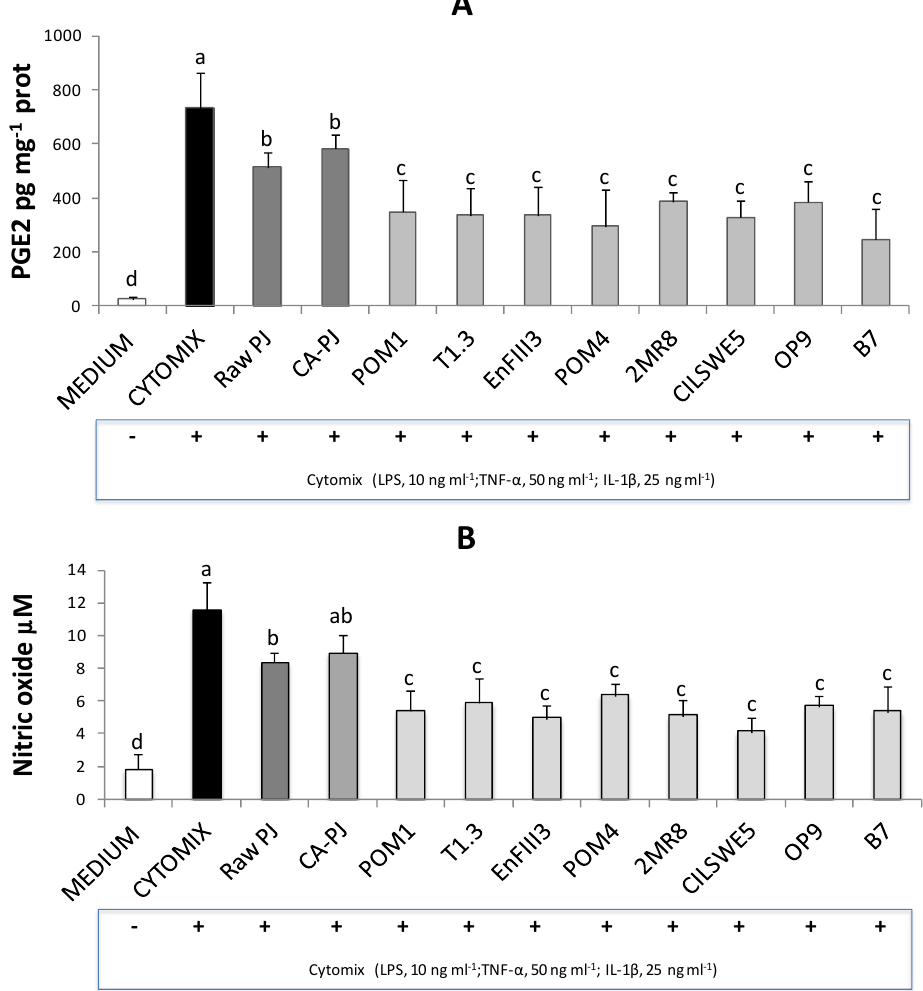
Figure 2. Prostaglandin E2 (PGE2) (pg mg − 1 of protein) (A) and nitric oxide (NO) ( µ M) (B) levels measured in Caco-2 cells pretreated for 6 h with raw Portulaca oleracea L. juice (Raw-PJ), chemically acidified PJ (CA-PJ), and PJs fermented (30 ◦ C for 36 h) by Lactobacillus plantarum POM1, T1.3, and EnFIII3, Lactobacillus brevis POM4, Lactobacillus rossiae 2MR8, Pediococcus pentosaceus CILSWE5, Leuconostoc mesenteroides OP9, and Lactobacillus kunkeei B7, then stimulated with the inflammatory cytomix for 24 h. Bars with different superscript letters differ significantly ( p < 0.05).